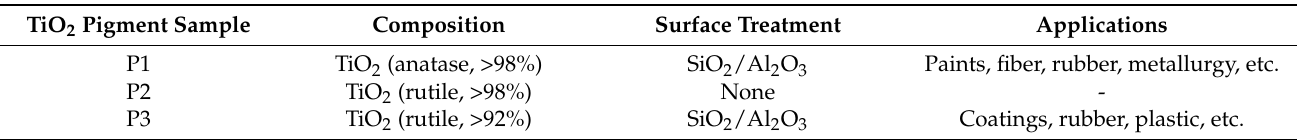
Table 1. Main characterization of industrial TiO 2